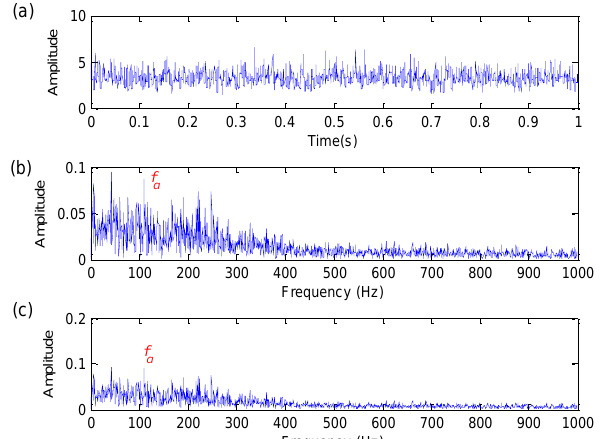
Figure 7. Analysis results obtained by STH method for simulation signal: ( a ) Time domain waveform; ( b ) amplitude spectrum; ( c ) envelope spectrum.